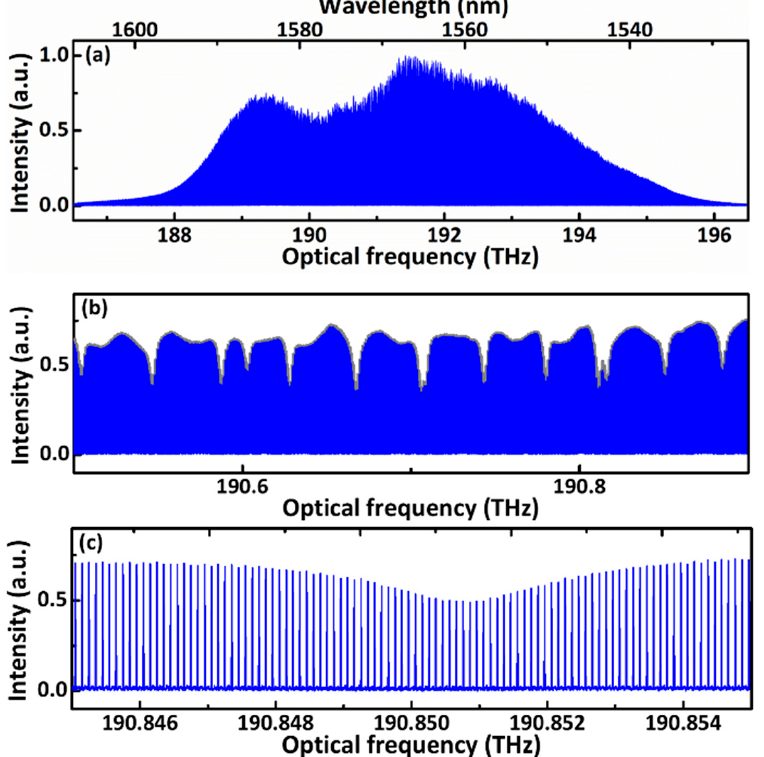
Figure 4. The spectrum around 193 THz with resolved comb lines. ( a ) The entire spectrum across the entire domain of emissions of the laser oscillators. ( b ) A 25× view near the absorption peaks. ( c ) A 1000× view near an absorption peak with resolved comb lines.